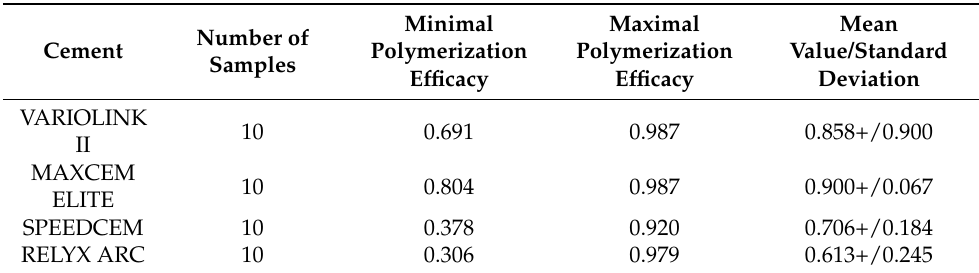
Table 2. Minimal, maximal and mean polymerization efficacy, along with standard deviation, for the four studied materials.